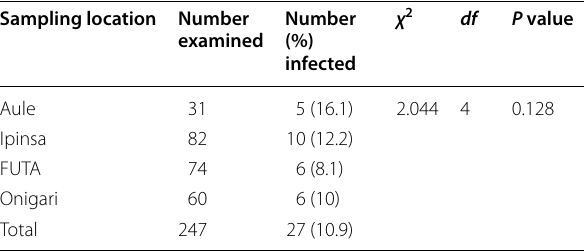
Table 2 The prevalence of Cryptosporidium oocysts according to sampling